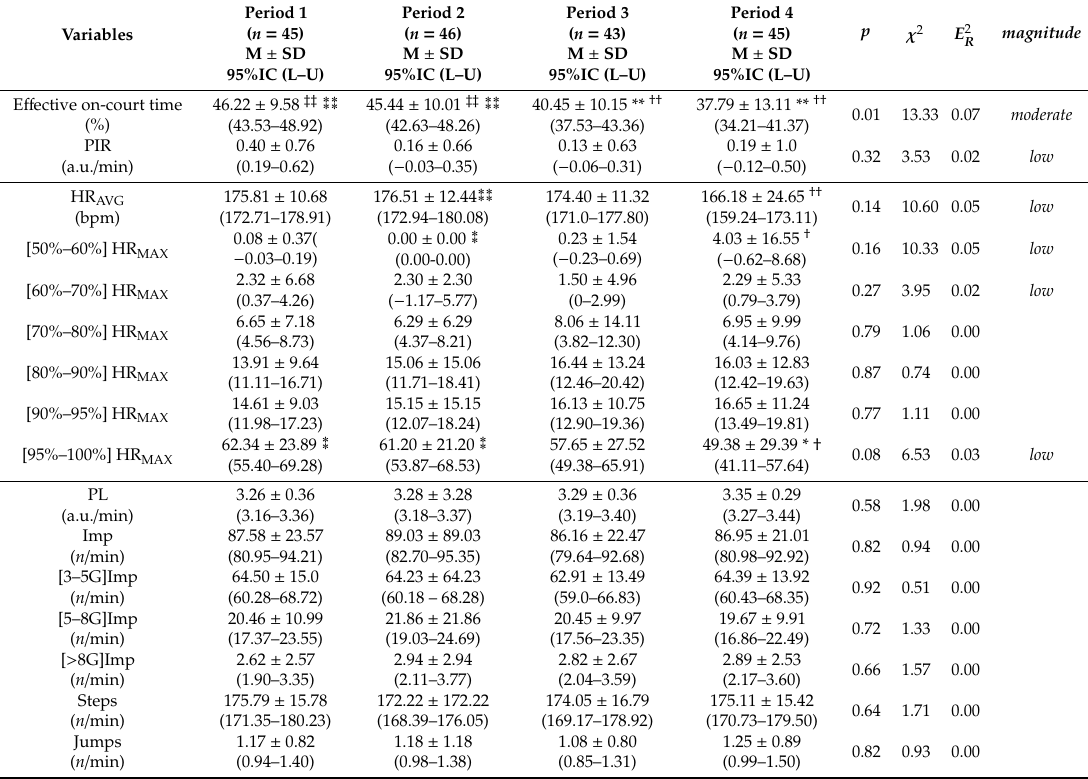
Table 4. Descriptive and inferential analysis of the analyzed variables in function of the match